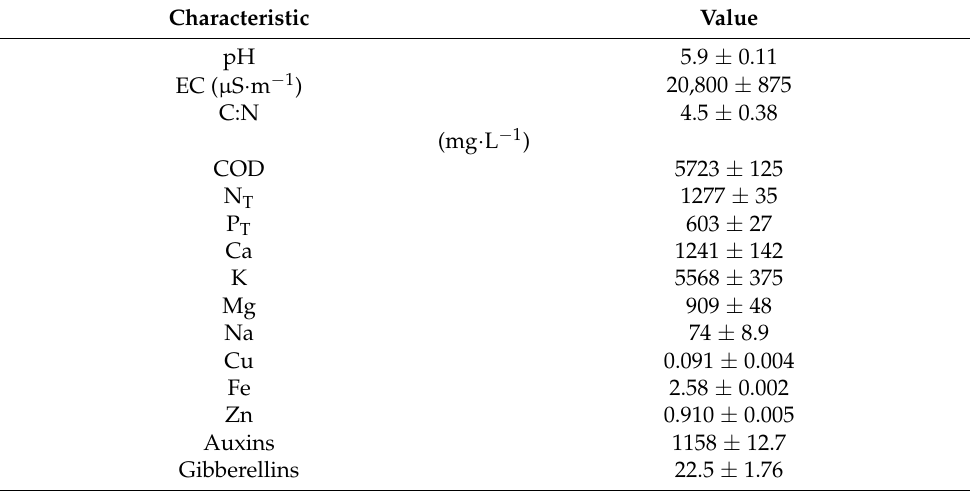
Table 2. Characteristics of the nopal-based biofertilizer used in this